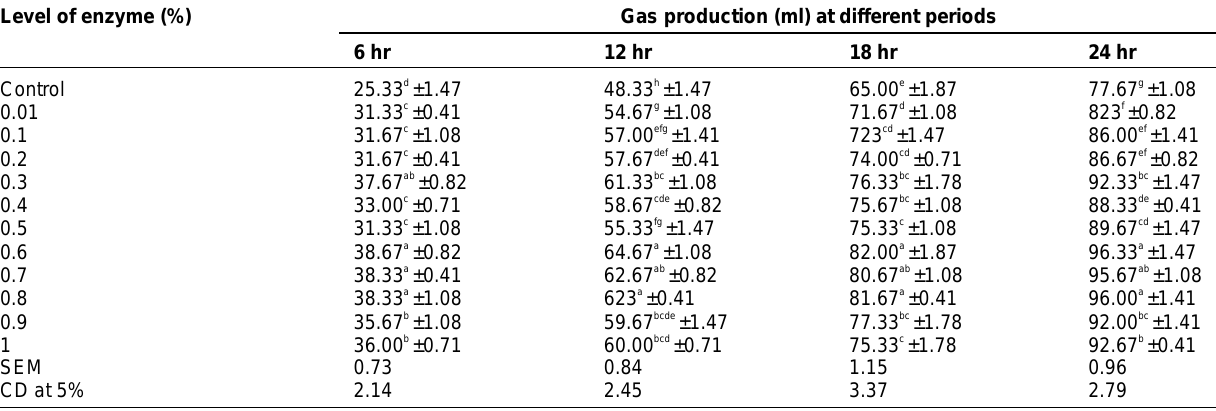
Table-3. Effect of mixture of neutral cellulase + fungal xylanase (1:1) on in vitro gas production (ml) from dry jowar Level of enzyme